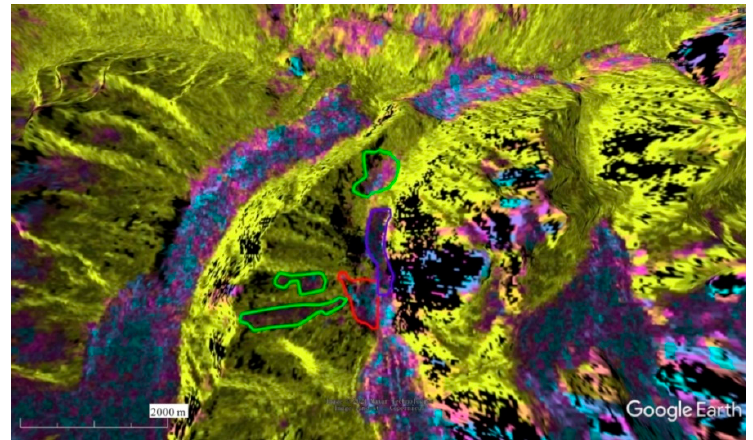
Figure 6. Sliding zones detected based on the filtered coherence map. The colorscale of coherence map (blue-red-yellow) indicates the coherence value from 0.1 to 0.9. The black pixels denote the shadow or layovered areas. The purple, red and green polygons denote the Jiwenco glacial lake (JGL), the collapsed landslide bodies on 21 June, and possible landslides with low coherence areas, respectively.